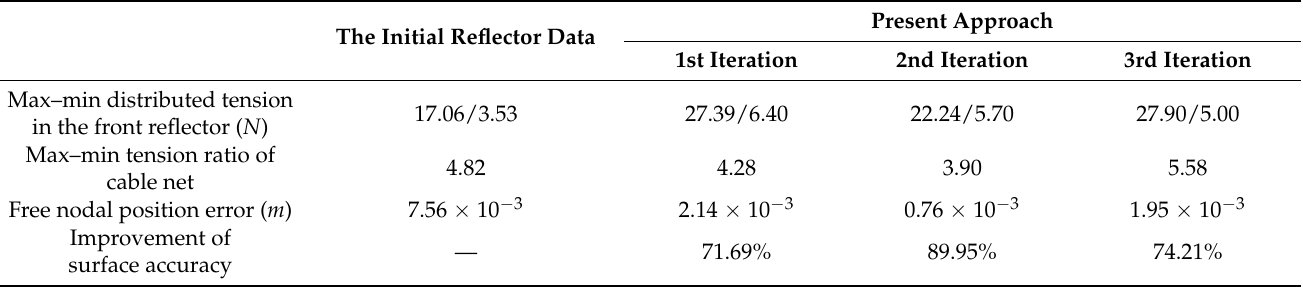
Table 2. Comparison of the design results using the proposed and the conventional